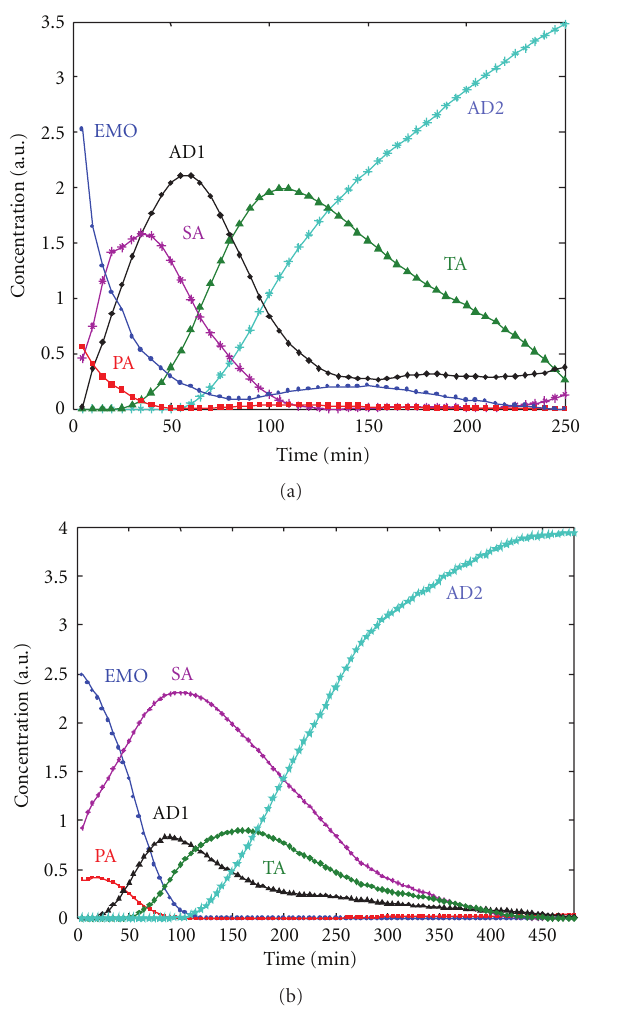
Figure 3: Concentration profiles of the species recovered by MCR- ALS (a) T a = 60 ◦ C; (b) T a = 30 ◦ C. ( (cid:2) ) EMO; ( (cid:2) ) aniline; ( ∗ ) secondary amine (SA); ( (cid:3) ) amide (AD1); ( (cid:4) ) tertiary amine (TA); ( (cid:2) ) tertiary amine (AD2).